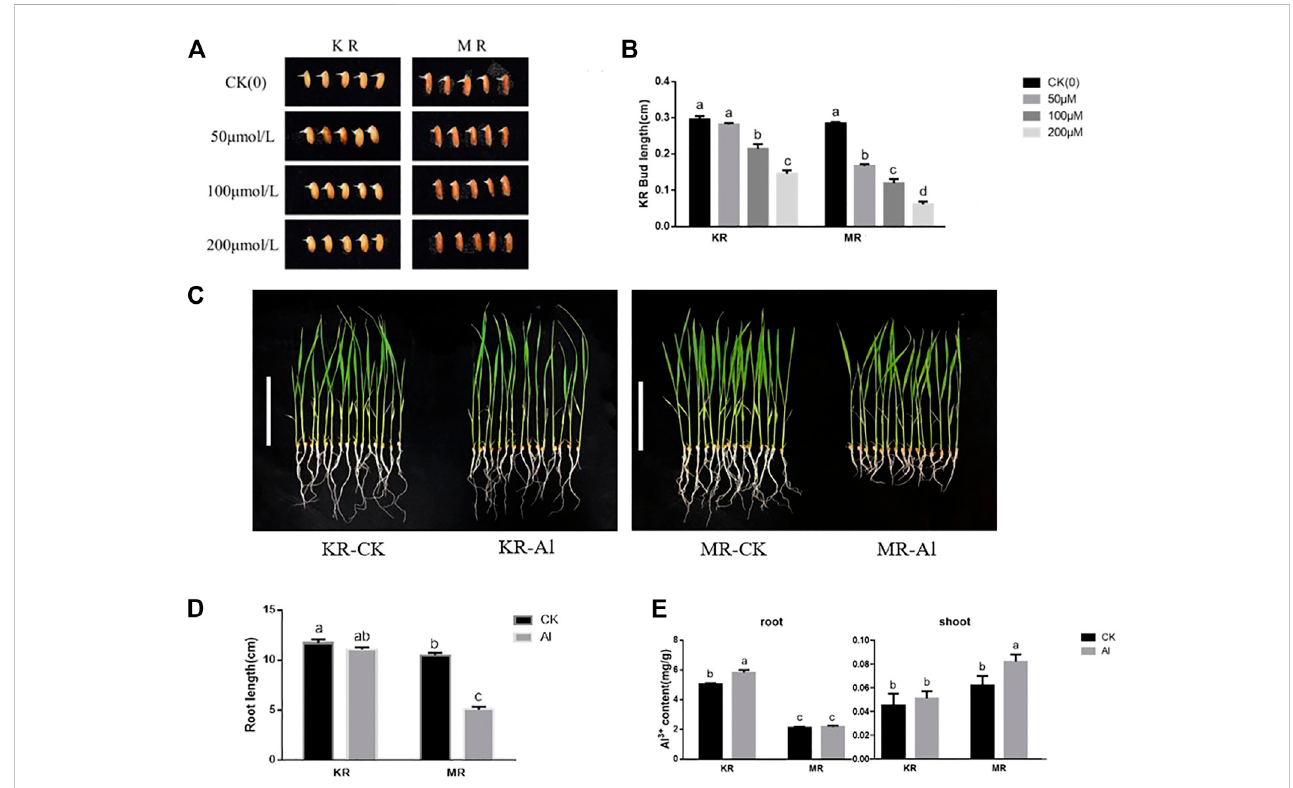
FIGURE 1 Budlengthandrootgrowthonricelandraces(KR-Altolerant;MR-Alsensitive)underAlstress. (A) EffectbyAlstressonPhenotypeofriceatbudstage. (B) Bud length of rice under Al stress. (C) Effect by Al stress on Phenotype of rice seedlings (Bar represent the 10 cm). (D) Effect by Al stress on root length of rice seedlings. (E) The content of Al ions absorbed by rice seedling under Al